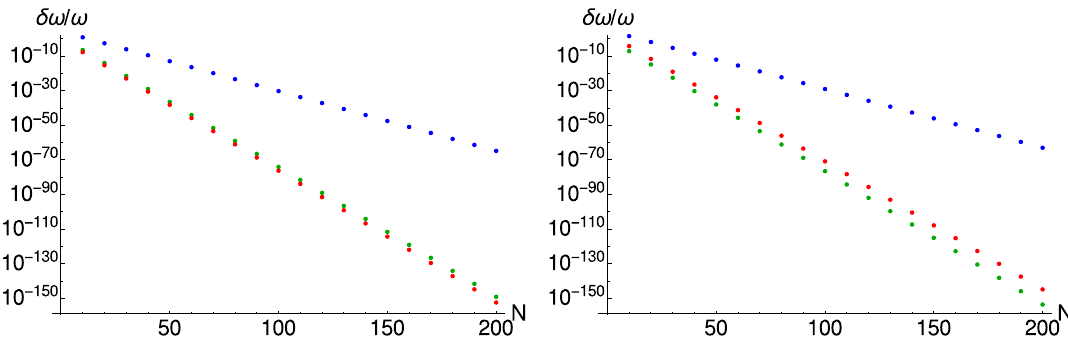
Figure 1 . The accuracy of the (cid:12)rst three numerical QNM frequencies from the (cid:12)rst set in compar- ison with analytical formula for M = 0 : 5 for Z 1 (left panel) and Z 2 (right panel). The horizontal axis shows the number of grid points along the radial coordinate and green, red and blue dots correspond to the n = 0 ; 1 ; 2 QNMs respectively. It is interesing that in this case the (cid:12)rst mode in the Z 1 family has higher accuracy than the zeroth